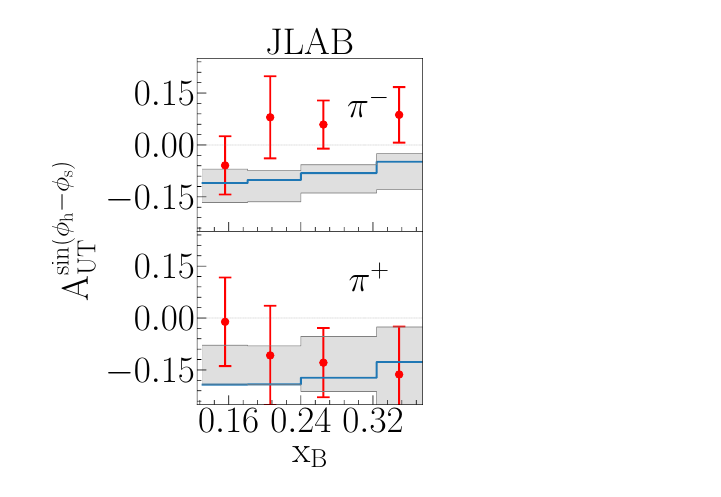
Figure 18 . JLab measurement of the Sivers asymmetry for a neutron target [45] as a function of x B . The central curve and uncertainty band are generated using the result from fit 2b in table 1.